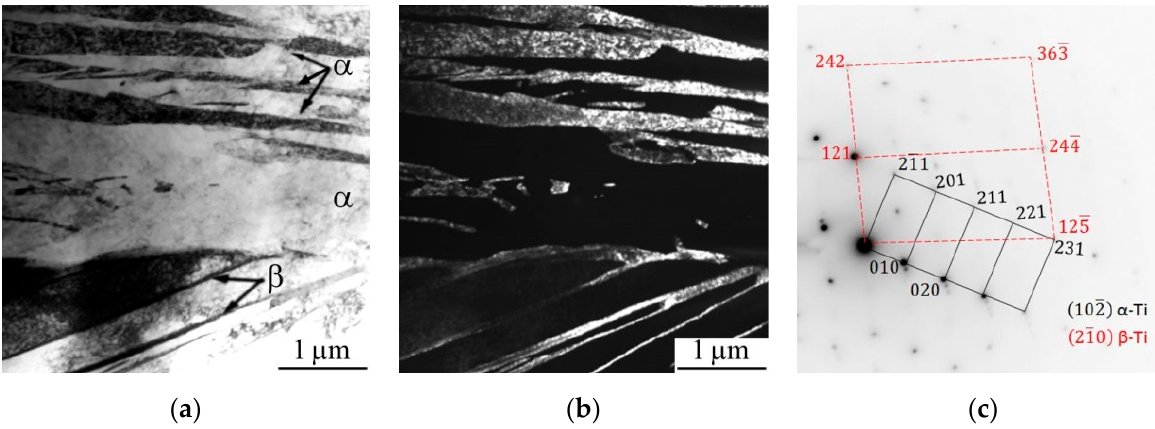
Figure 8. Bright- ( a ) and dark-field TEM micrographs ( b ) and the associated SAED pattern with indexing scheme ( c ) of the microstructures of the EBAM Ti-6Al-4V samples produced with substrate cooling. The dark-field TEM micrograph was obtained with the closely spaced 231(cid:3435)102(cid:3439) α -Ti and 125(cid:3435)210(cid:3439) β -Ti reflections ( c ). The microstructure was obtained at a distance of 40 mm from the substrate.